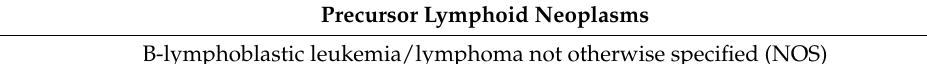
Table 1. WHO classification of precursor lymphoid